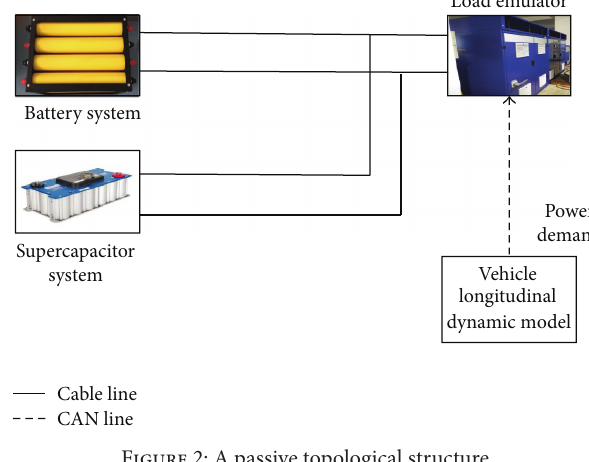
Figure 1: Comparison of battery and supercapacitor. Figure 2: A passive topological structure.